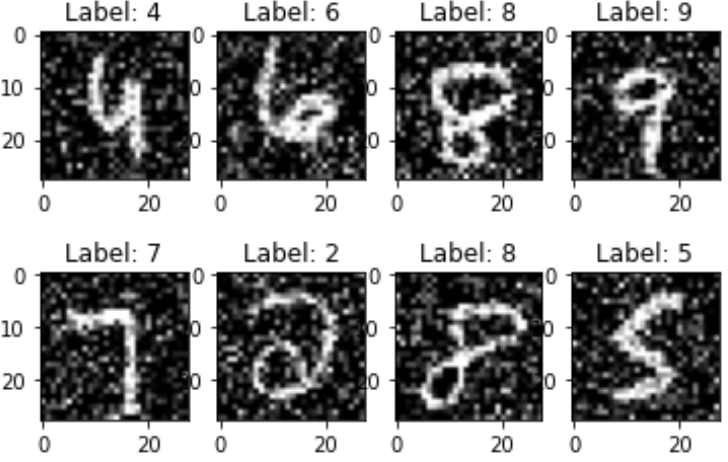
Figure 8. Image samples from the MNIST dataset with AWGN.